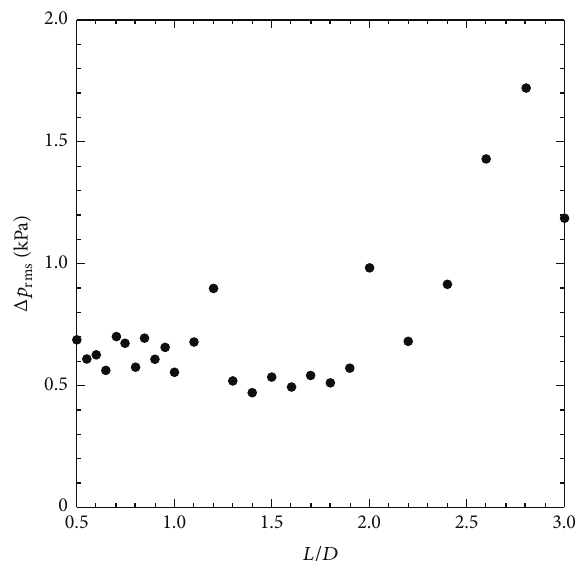
Figure 6: Plots of Δ𝑝 rms (location 𝑏 ) versus 𝐿/𝐷